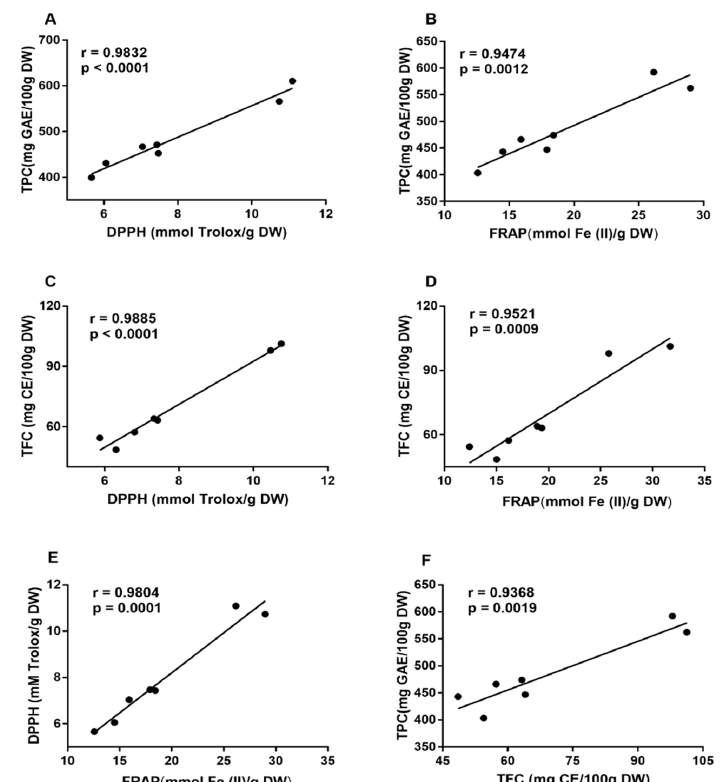
Correlation analysis. ( A ) Correlation between total phenolic content (TPC) and 1,1-diphenyl-2-picrylhydrazyl (DPPH) of germinated peanuts. ( B ) Correlation between TPC and ferric ion reducing antioxidant power (FRAP) of germinated peanuts. ( C ) Correlation between total flavonoid content (TFC) and DPPH of germinated peanuts. ( D ) Correlation between TFC and FRAP of germinated peanuts. ( E ) Correlation between DPPH and FRAP of germinated peanuts. ( F ) Correlation between TPC and TFC of germinated peanuts. GAE: gallic acid equivalent; DW: dry weight; CE: catechin equivalent.